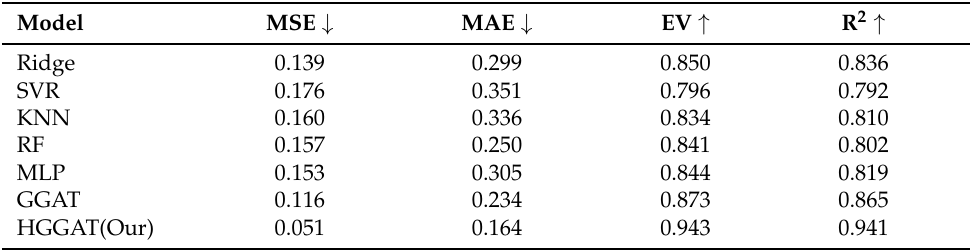
( ) means that, the higher (lower), the better (worse). ↑ ↓ MAE EV R 2 ↓ ↓ ↑ ↑